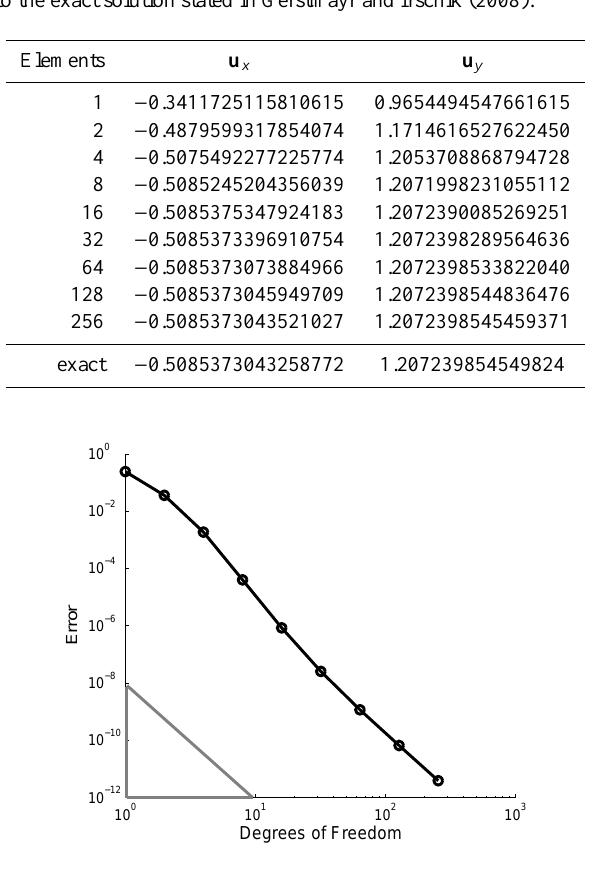
Figure 6. The error | u k − u | between computed and exact solution is plotted versus the degrees of freedom for the large bending example Fig. 6. The error | u k − u | between computed and exact solution is in Sect. 6.2. Actually, fourth order convergence may be observed plotted versus the degrees of freedom for the large bending example only in plane in Sect. 6.2. Actually, fourth order convergence may be observed only in plane problems.